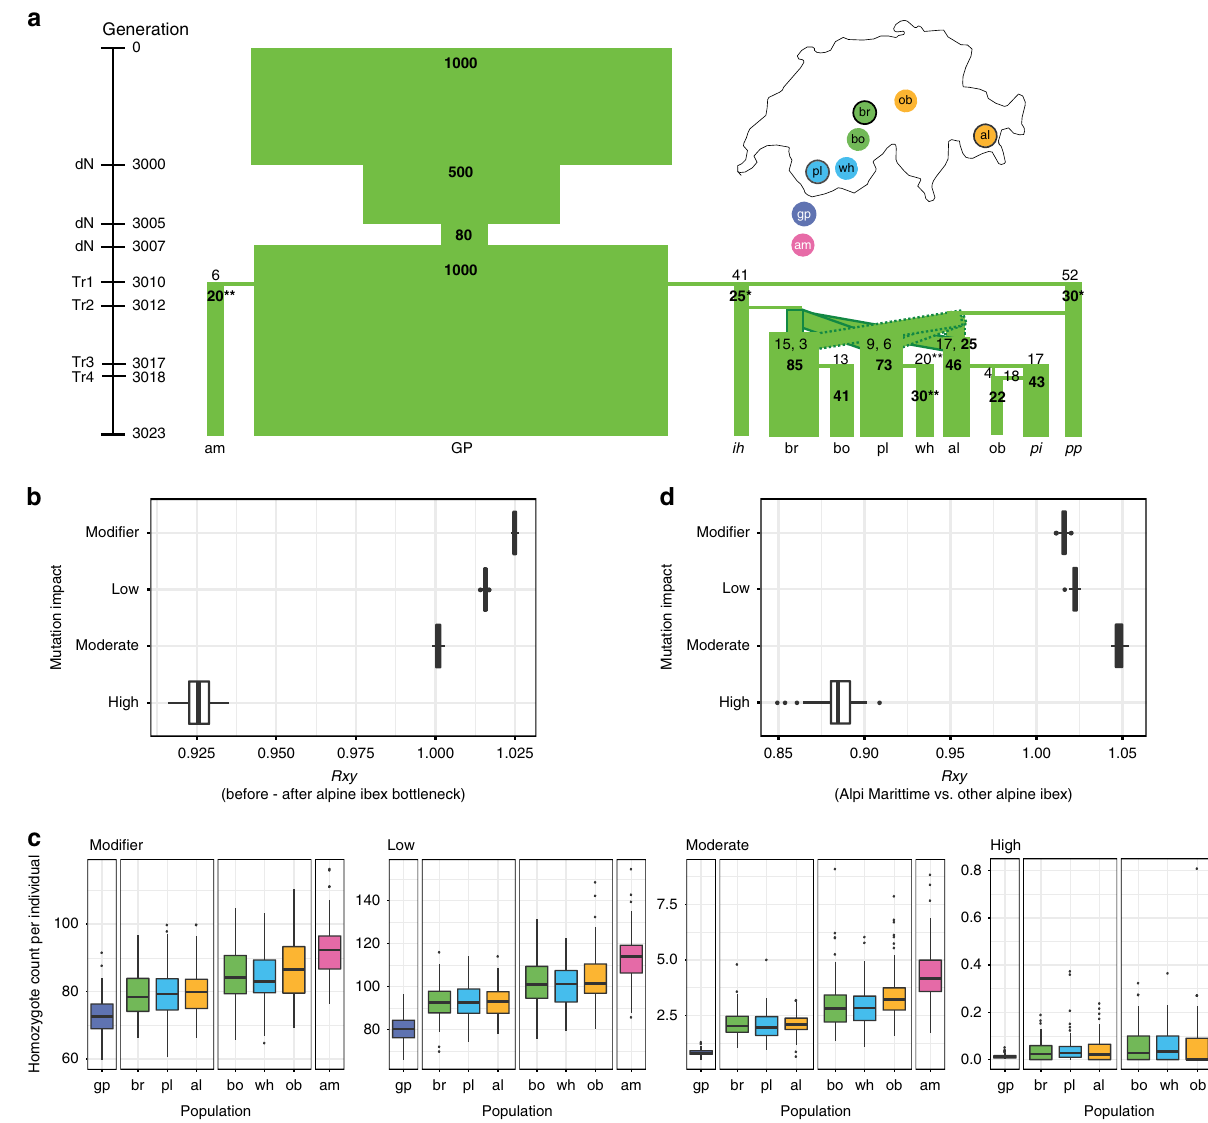
Fig. 6 Individual-based simulations of the reintroduction history of Alpine ibex. a The demographic model was parametrized using census data and historical records. Bold numbers show effective population sizes. Numbers not in bold indicate the number of individuals released to found each population. If a population was established from two source populations, the individual numbers are separated by commas. * Upwards adjusted harmonic means of the census size (historical records were ih = 16, Zoo Interlaken Harder, and pp = 20, Wildpark Peter and Paul). The adjustment was necessary to prevent extinction of zoo populations. ** Census numbers were estimated based on historical records of the population but no long-term census data were available. b Relative frequency comparison ( Rxy ) of Alpine ibex just before and after the species bottleneck and recolonization. c Individual homozygote counts per impact category. Boxplots summarize 100 population means across simulation replicates. Colors associate founder and descendant populations (see also Fig. 3a). d Rxy analysis contrasting the strongly bottlenecked Alpi Marittime population with all other Alpine ibex populations across the spectrum of impact categories. Box plot elements are de fi ned as in Fig. 1. Source data are provided as a Source Data fi